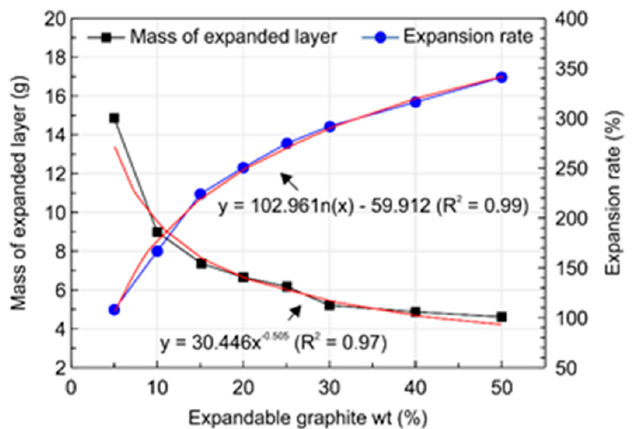
Figure 5. Expansion rate with expandable graphite content.